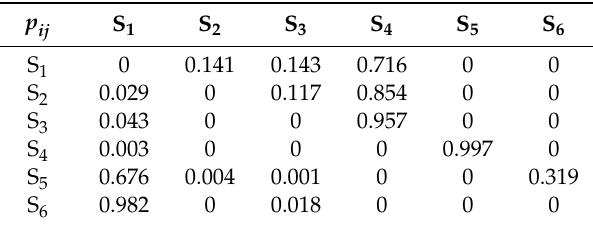
Table 4. The p ij inter-states transition probability